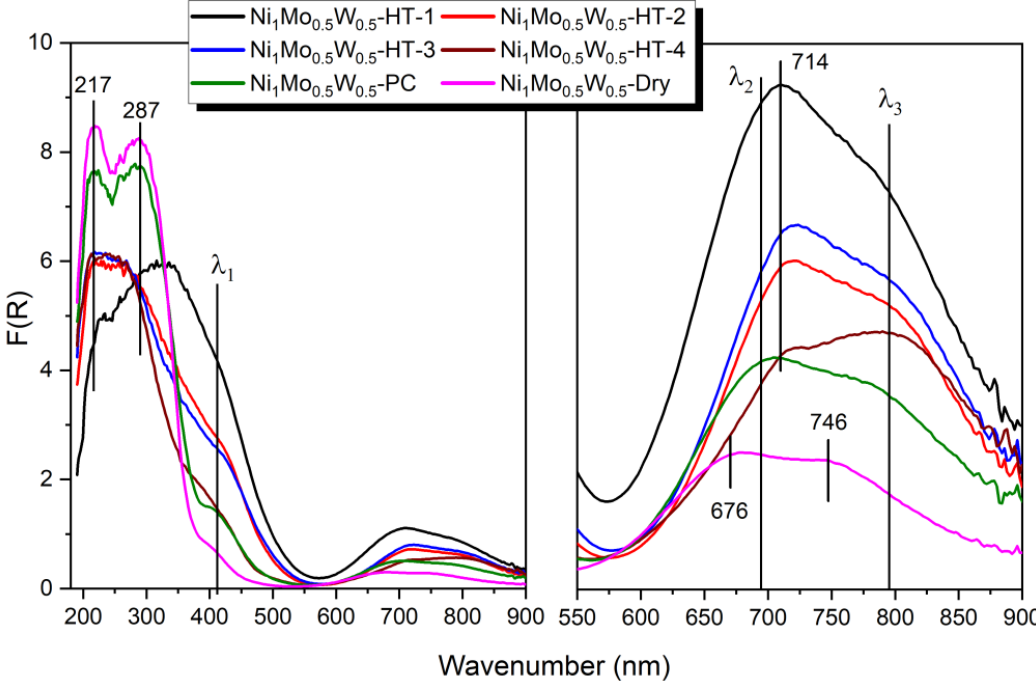
Figure 7. UV-vis DR spectra of catalyst precursors dried at 110 °C.